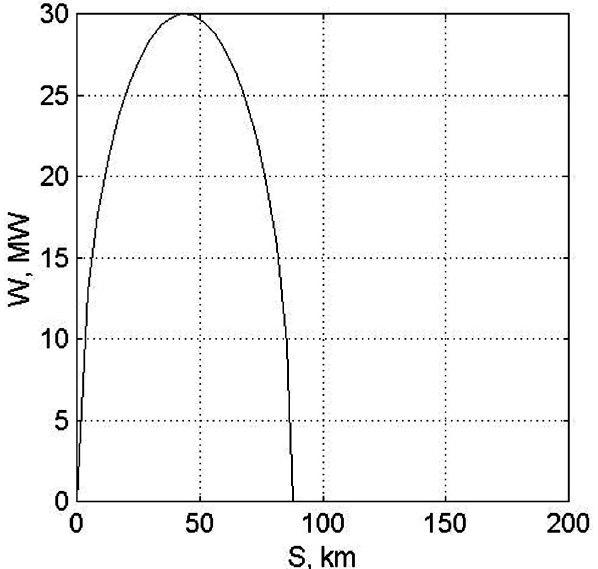
Fig. 2. The variation of the effective absorbed power (EAP) (in megawatts) along the considered part of the convection trajectory. On the horizontal axis, the distance from the beginning of the illu- minated region S (in km) at level h = 300km is shown. The center of the illuminated region lies at the distance of approximately 44km where the EAP achieves the maximal value.